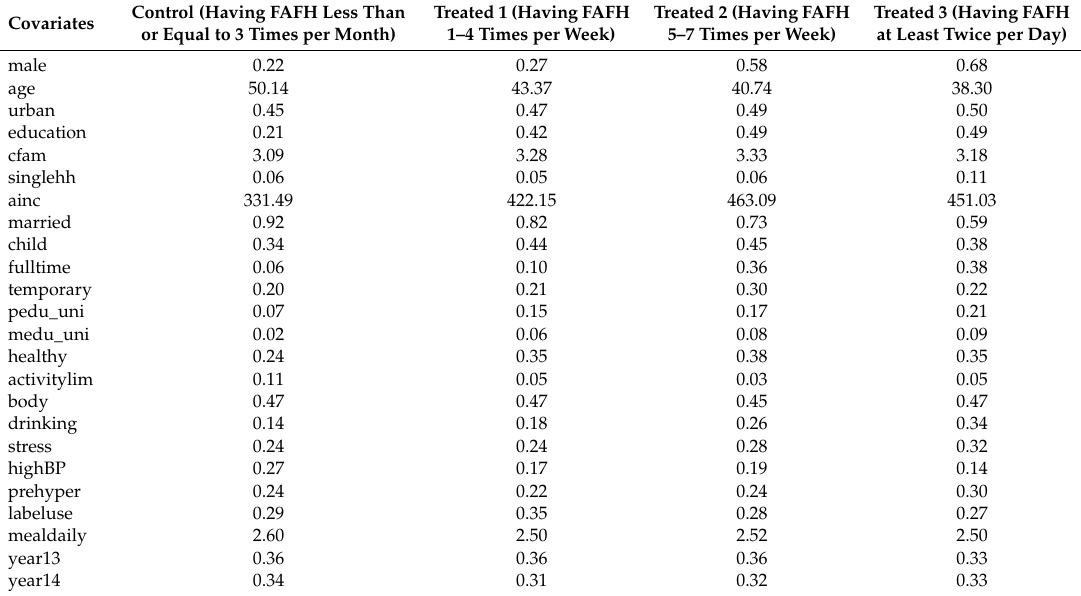
Table 5. The baseline means for control and hypothetically treated groups.